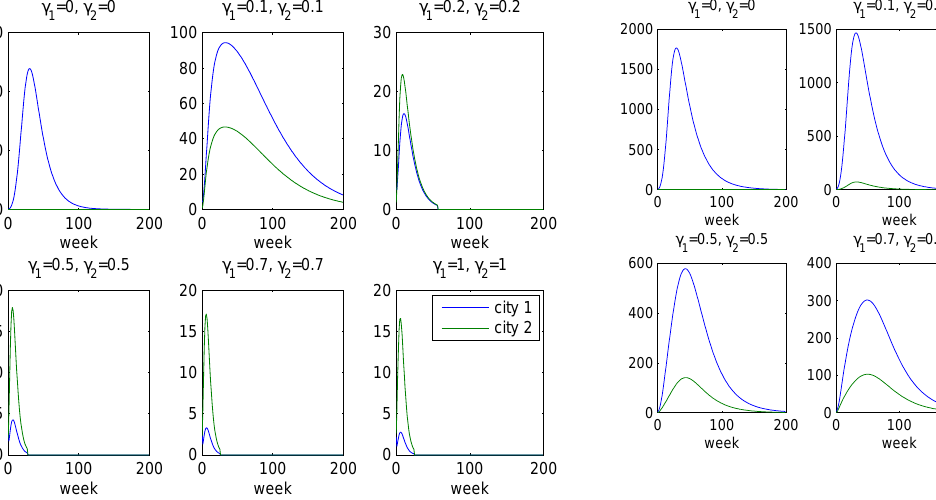
Fig. 9. Simulation of the evolution of the infected population per week for different values of γ and M c = 0 . 1 .